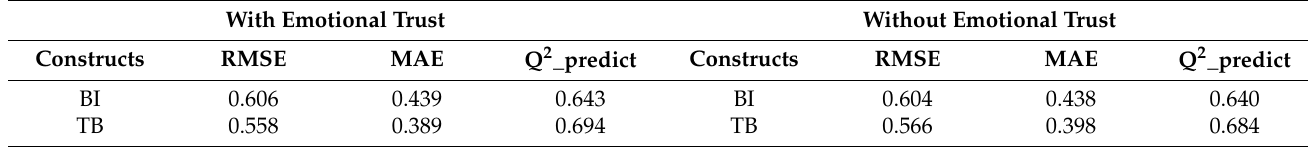
Table 11. PLSpredict